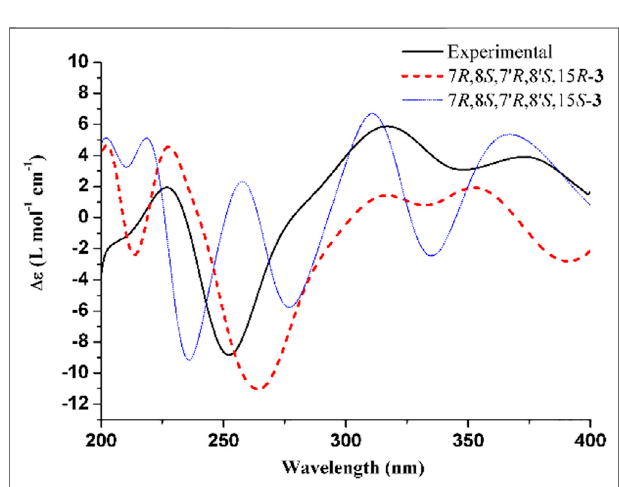
FIGURE 3 | Experimental ECD spectrum of 3 and calculated ECD spectra for (7 R ,8 S ,7 ′ R ,8 ′ S ,15 R )- 3 and (7 R ,8 S ,7 ′ R ,8 ′ S ,15 S )- 3. The band width was set to 0.18